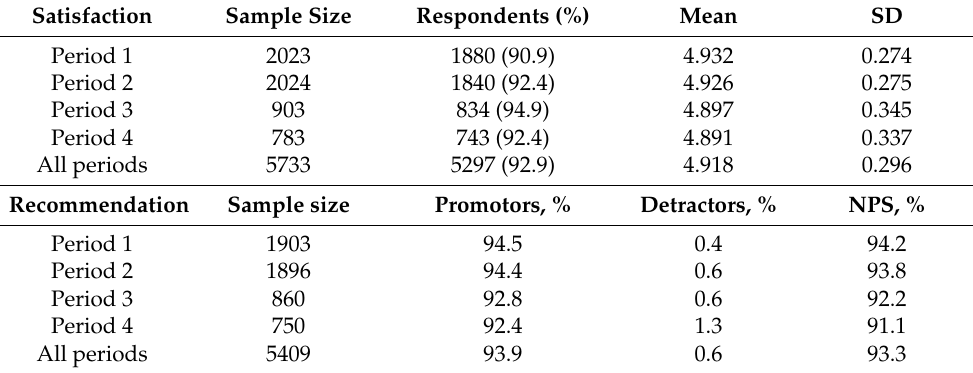
Table 3. Respondent satisfaction with pharmacist-administered COVID-19 vaccination, using satis- faction score from 1 to 5, and likelihood of recommending the pharmacy vaccination service, using NPS